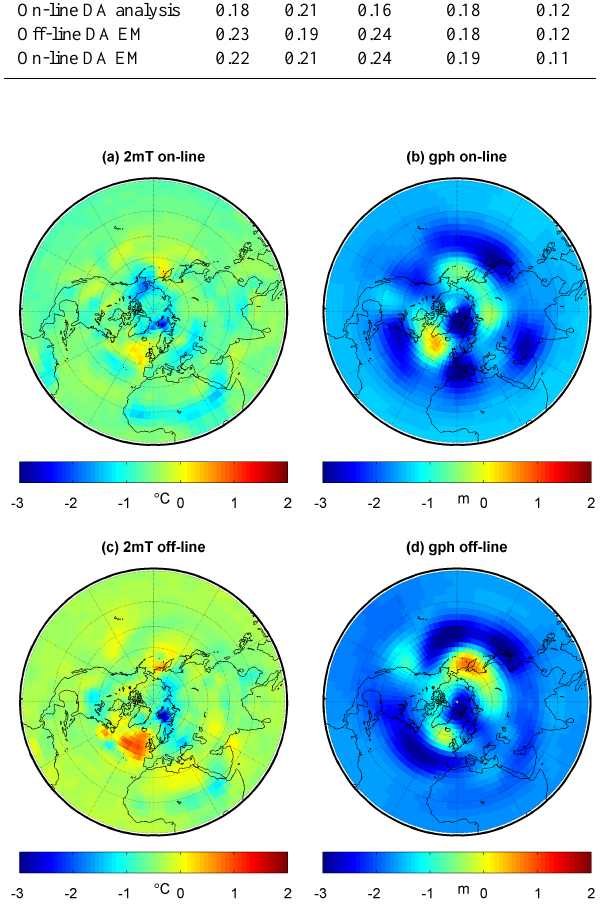
Figure 7. Analyses of the on-line and off-line DA methods for the 2m mean temperature (anomalies w.r.t. the AD1961–1990 mean) and 500hPa geopotential height (anomalies w.r.t. the AD1961– 1990 mean) of the decade AD1640–1649.